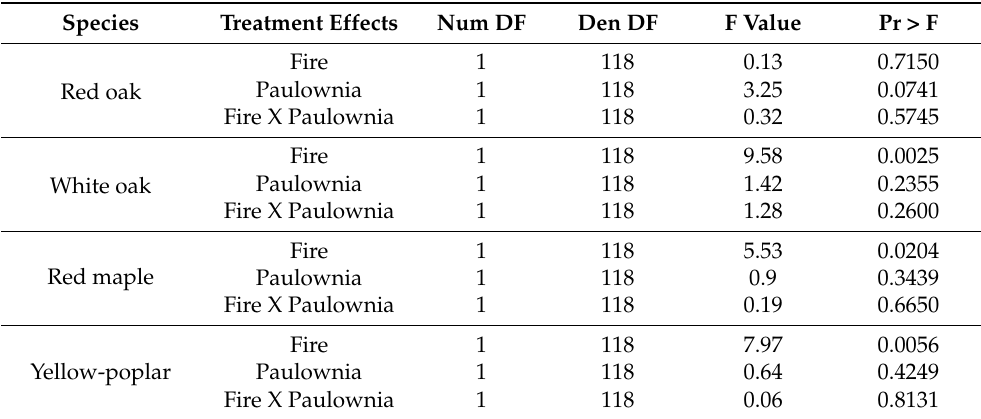
Table 3. The negative binomial model statistics for the main effects of fire (fire/no fire), paulownia (presence/absence), and their interactions to predict the number of stems per hectare by species. Species Treatment Effects Num DF Den DF F Value Pr > F Red